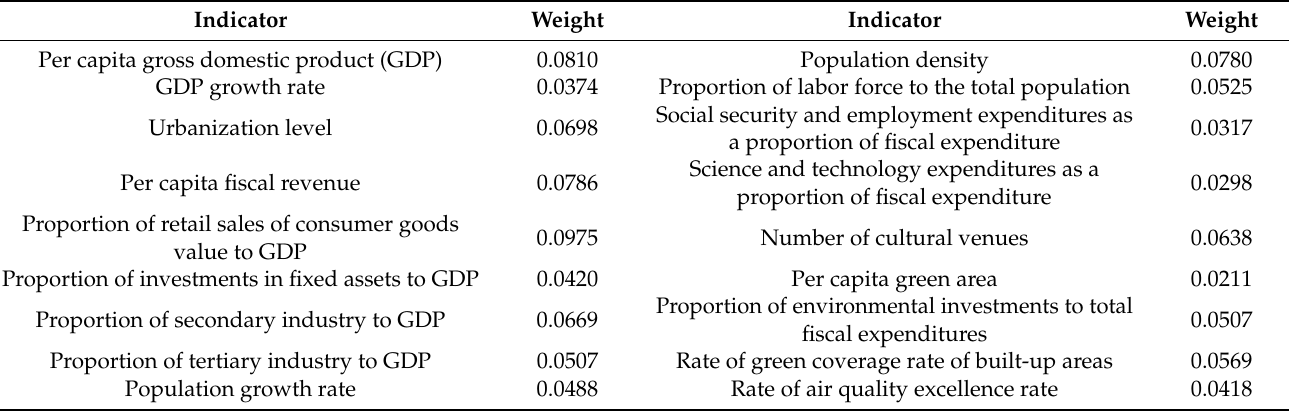
Table 2. The weight of evaluation indicators system.